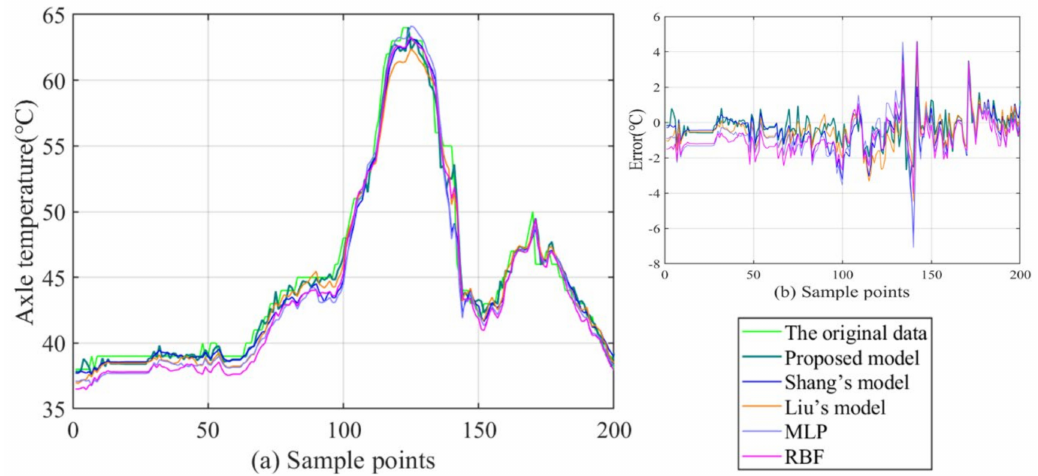
Figure 14. Prediction results and errors of series #2: ( a ) prediction results; ( b ) error distribution.